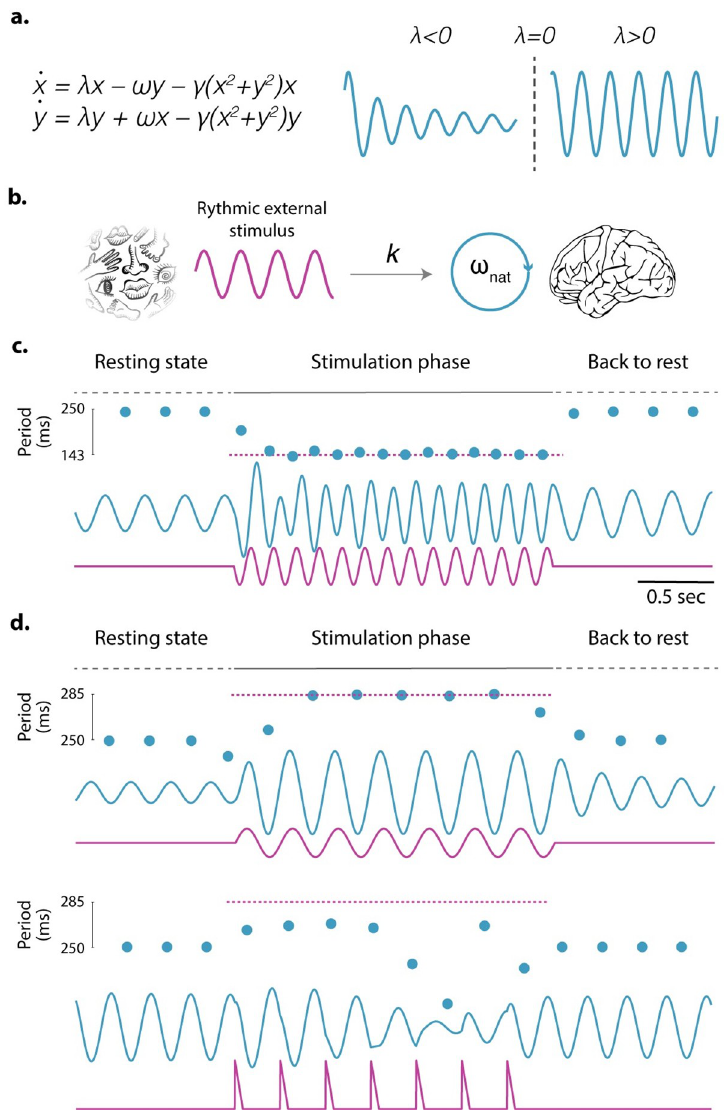
Fig 1. A neural oscillator can be represented by an HA bifurcation. (a) The set of equations displayed in the figure, known as Stuart–Landau equations, goes through an HA bifurcation at λ = 0. For λ below this critical value, x(t) (blue trace on the left) shows a damped oscillatory regime; when λ surpasses 0, x(t) (blue trace on the right) starts oscillating with a frequency of ω . (a) Schematic representation of the oscillator driven bottom-up by an external rhythmic stimulus. Simulations are run for a neural oscillator with a natural frequency ω nat = 4 Hz forced by a periodic external stimulus of period τ , s(t) = s(t + τ ). The external stimulus is added as an extra term in the equation driving x’s dynamics. The set of equations in panel a is modified as _ x _ ¼ l x (cid:0) o y (cid:0) g ð x 2 þ y 2 Þ þ k s ð t Þ . The parameter k nat represents the strength of the coupling between the neural oscillator and the external stimulus. (c and d) Oscillator’s response (x(t), blue traces) when forced by different rhythmic stimuli (magenta traces). Blue dots: time evolution of the oscillator’s period. Magenta dashed line: period of the external stimulus. For all simulations, parameters were fixed at ω nat = 2 π 4, λ = 0.1 and γ = 1. For panel c , k = 25 and s(t) a sinusoid with a frequency fixed at 7 Hz. For panel d , k = 50 and s(t) is a sinusoid, for the upper panel, and a periodic train of triangle pulses for the lower one, both with a frequency fixed at 3.5 Hz. HA,